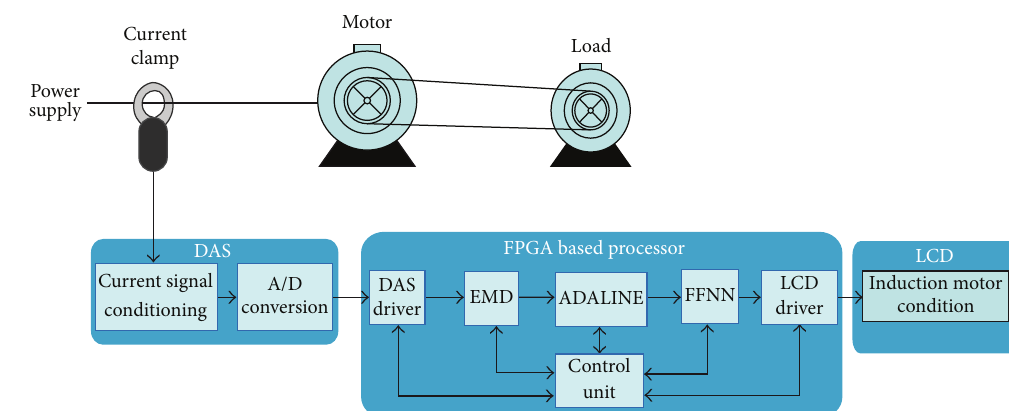
Figure 4: Proposed methodology for fault diagnosis in induction motors.